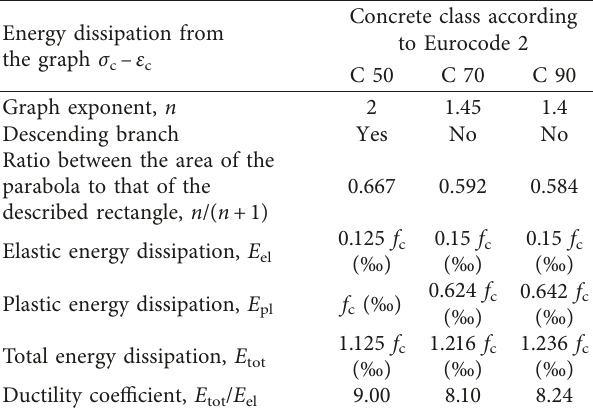
Table 1: Energy dissipation comparison for concrete classes C 50, C 70, and C 90.